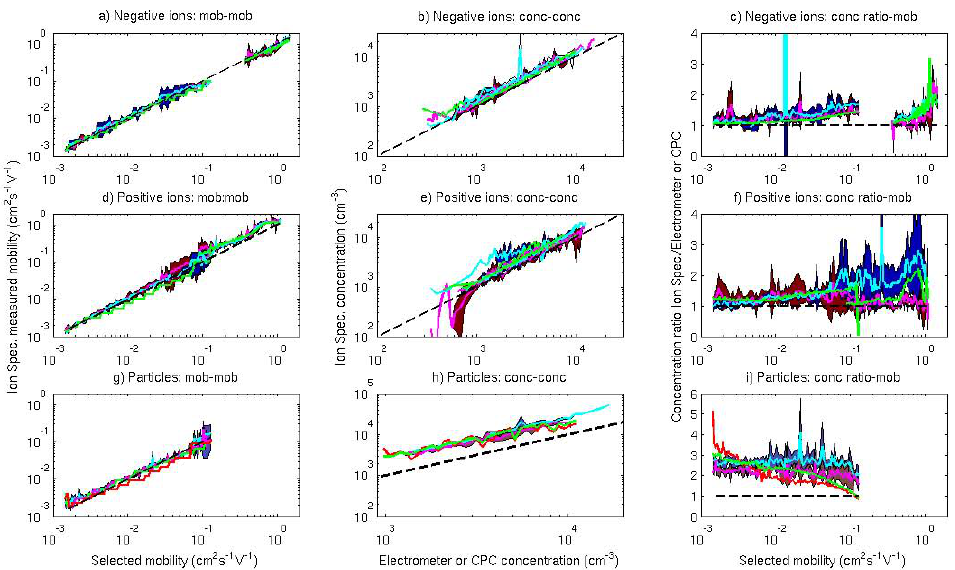
Fig. 4. Comparison of the ion spectrometers to reference instruments. (a) , (b) , (c) : negative polarity; (d) , (e) , (f) : positive polarity; (g) , (h) , (i) : total particles (charged+neutral, NAISs only). Panels (a) , (d) and (g) display the mobility measured by the ion spectrometers as a function of the mobility selected by the DMA. Panels (b) , (e) and (h) display the total concentration measured by the ion spectrometers as a function of the concentration measured with reference instruments. Panels (c) , (f) and (i) display the ratio of the ion spectrometer concentration to the concentration of the reference instrument as a function of the particle mobility. In panels (a) to (f) , the AISs are represented by magenta lines and red filling (standard deviation between instruments), the NAISs by cyan lines and blue filling, and the ANAIS by a green line. The electrometer is the reference instrument in these two lines. In panels (g) , (h) and (i) , the total particles, cyan lines and blue fillings correspond to the negative DMAs of the ion spectrometers; magenta lines and red fillings correspond to the positive DMAs of the ion spectrometers. The green and red lines represent the negative and positive DMAs of the ANAIS, respectively. The reference instrument is the CPC in this line. The black dashed lines are the ideal values. All the points in this figure were obtained from calibration with silver